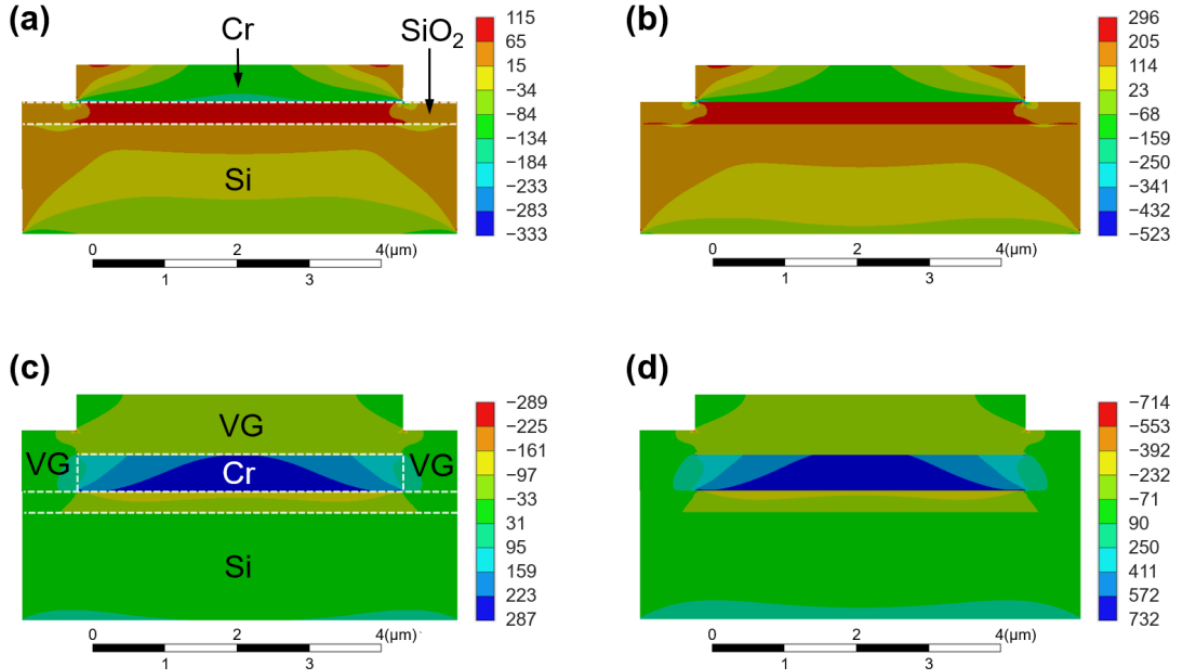
Figure 5. Stress (in MPa) distributions in the SiO 2 /Si substrate with patterned Cr film at ( a ) 300 ◦ C and ( b ) 600 ◦ C during heating before synthesis of VG. Stress (in MPa) distributions in the SiO 2 /Si substrate with VG and patterned Cr film at ( c ) 600 ◦ C and ( d ) 300 ◦ C during cooling after synthesis of VG.